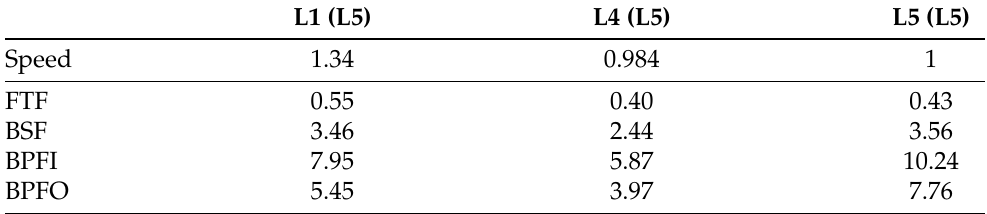
Table 3. Fault bearing frequencies of supporting shafts L1, L4, L5, with speed of L5 as reference.